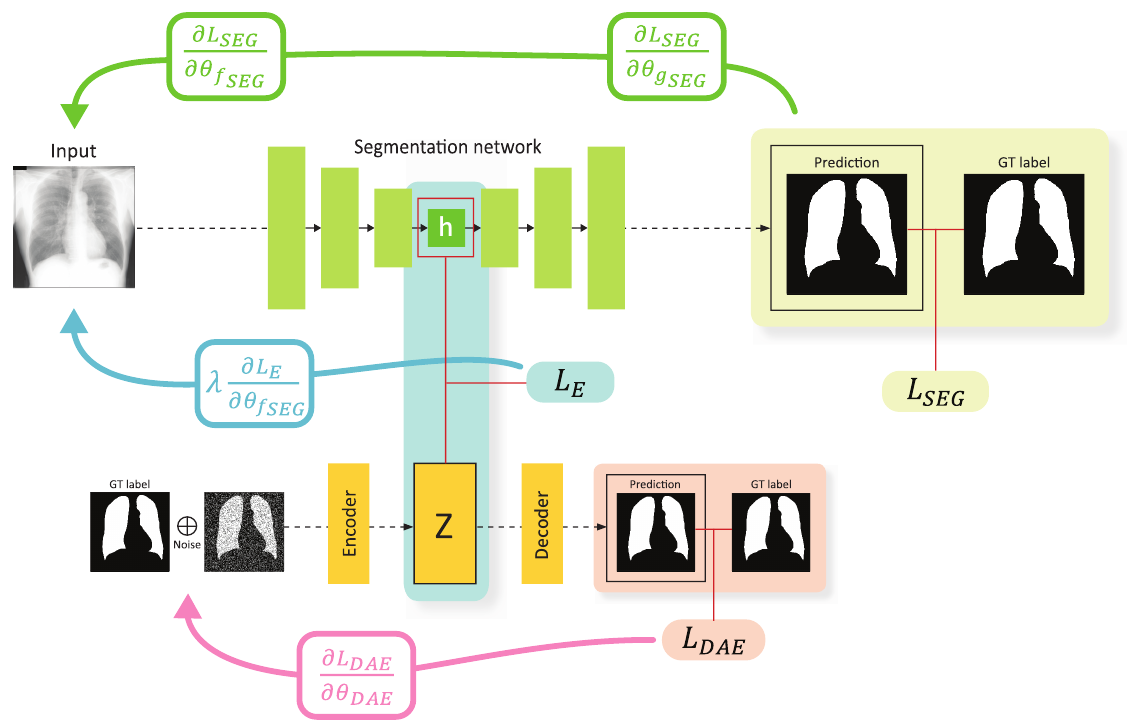
Figure 2. Training scheme of the proposed method. The green, blue, and red arrows show the gradient flow from L SEG , L E , and L DAE , respectively. Note that the gradient from L E flows only through the encoder of the segmentation